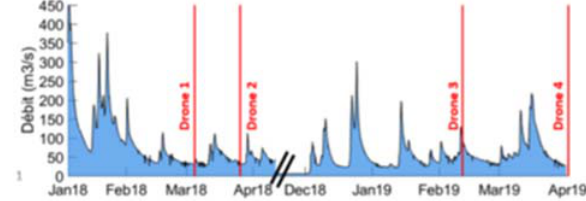
Figure 7: Hygrogram recorded during the studied year